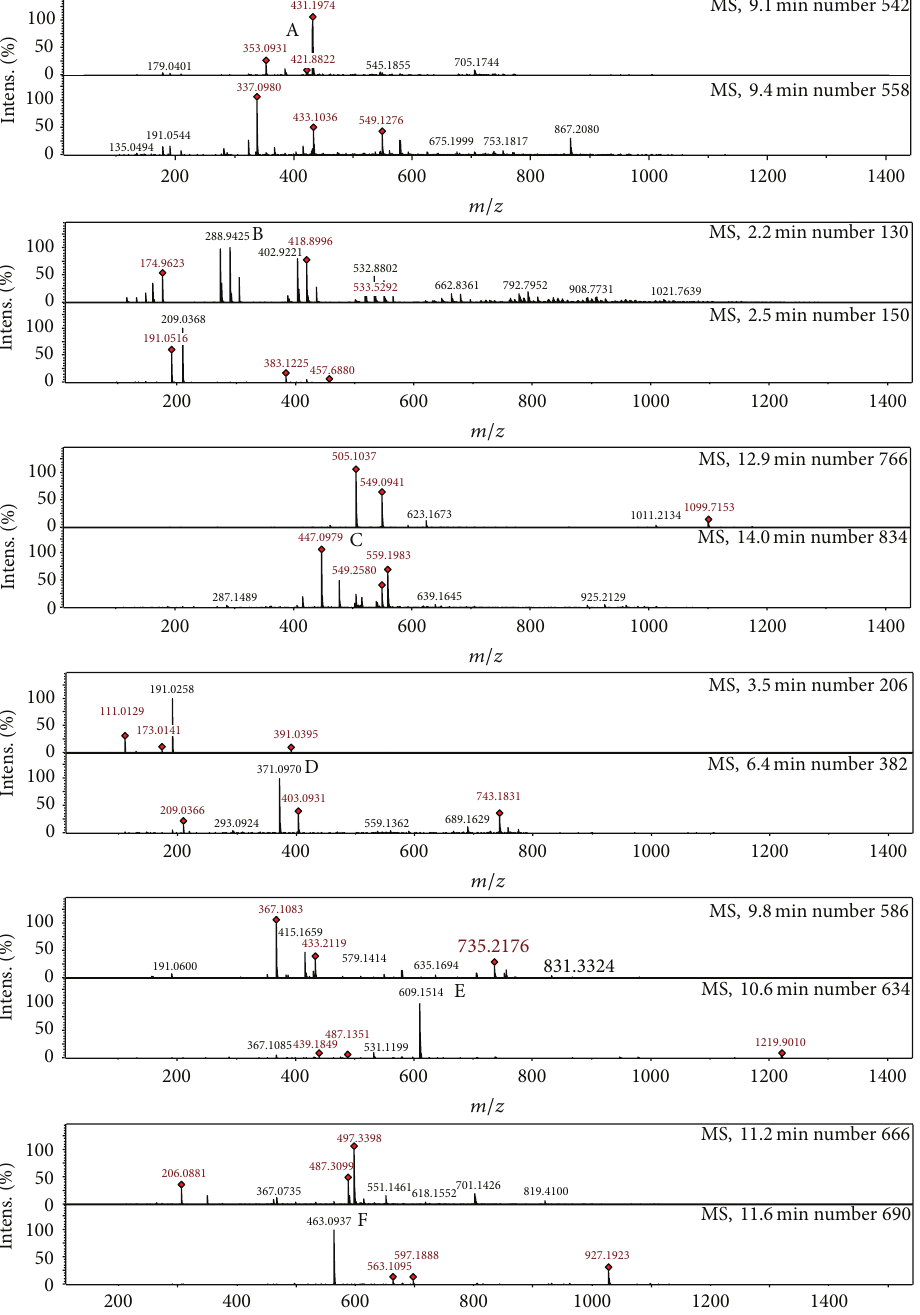
𝜇 mol/g sample. All determinations were done in tripli- cates. standard deviations. The significance of difference